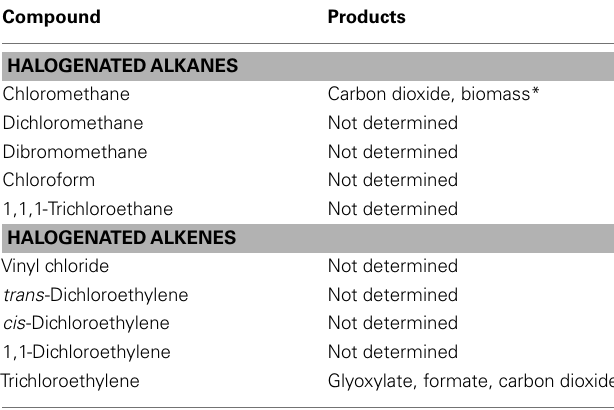
Table 3 | Halogenated hydrocarbons degraded by